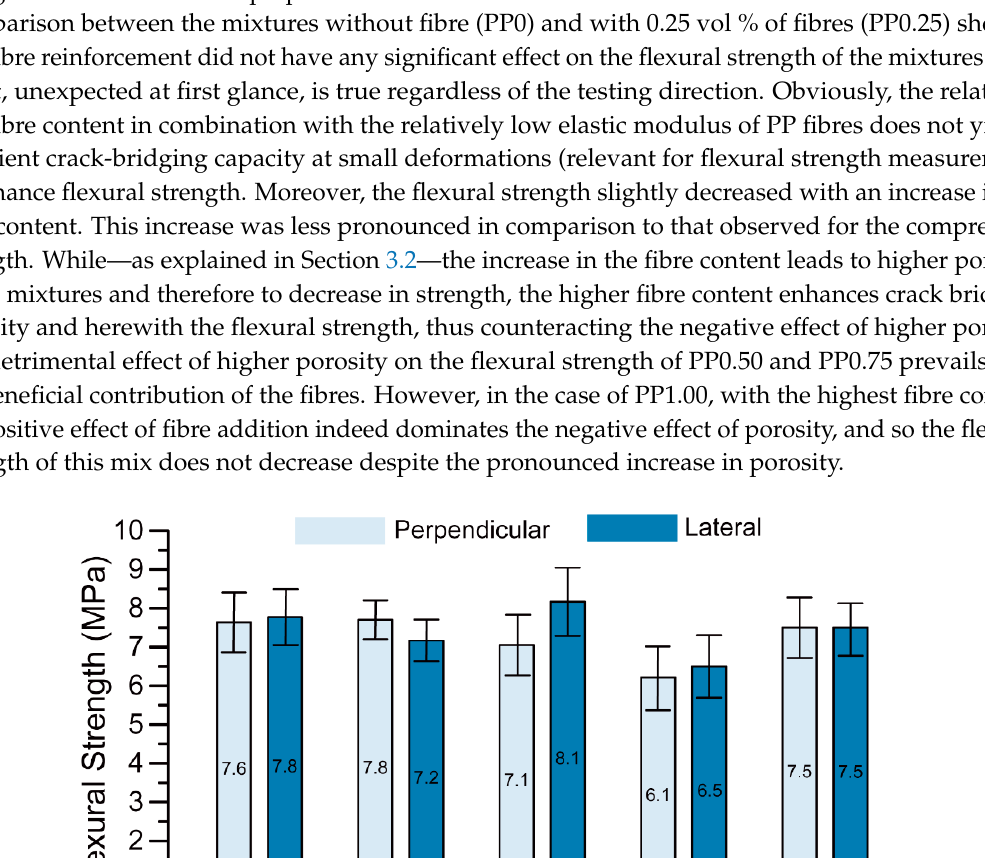
Figure 10. The flexural stress versus mid-span deflection curves for 3D-printed specimens subject to flexure in the perpendicular direction.